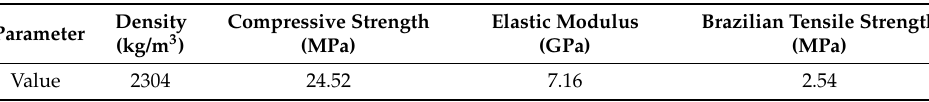
Table 3. Mechanical properties of the rock samples.